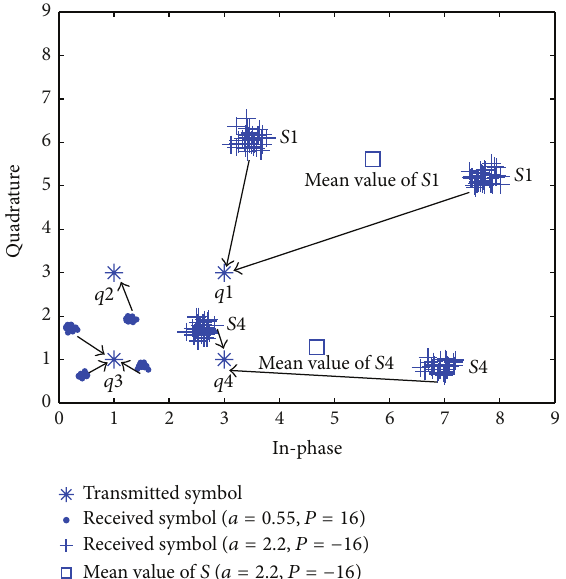
Figure 2: Square 16QAM symbols with different fading coefficients (first